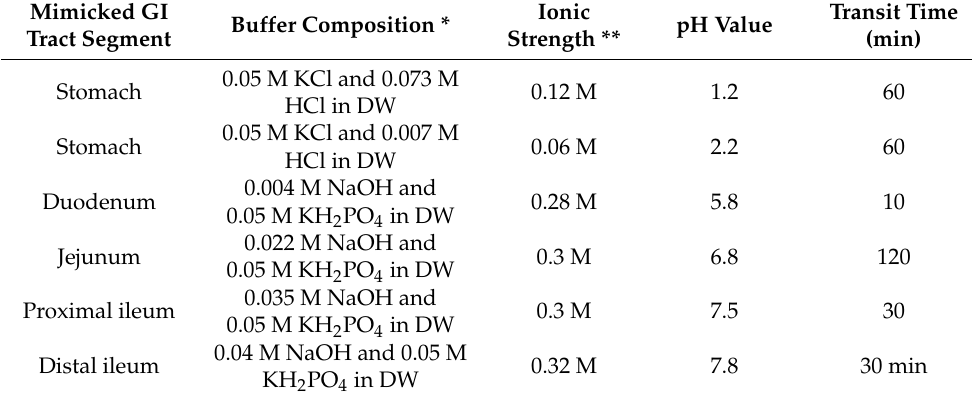
Table 2. Composition, pH values and transit time of each buffer used in biodissolution test. Mimicked GI Buffer Composition Tract Segment